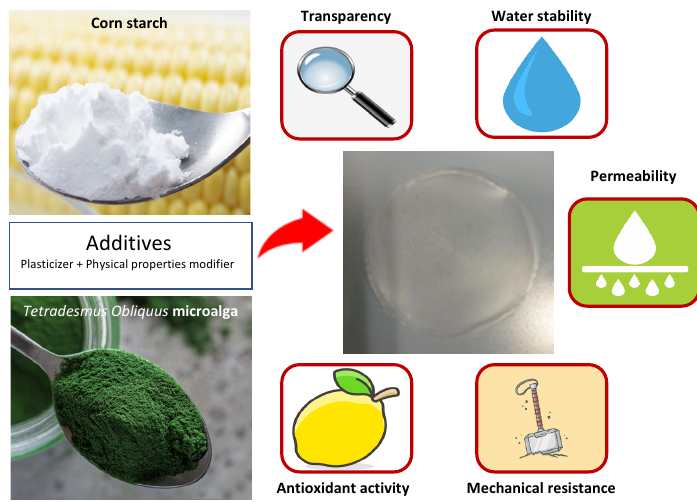
Scheme 1. Illustration image highlighting the aims and activities of the study.